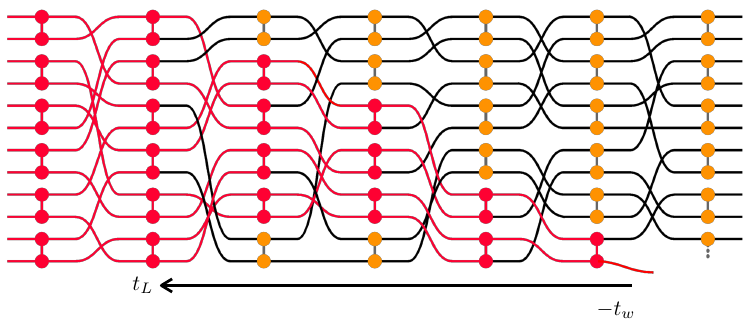
Figure 1 . Illustration of the quantum circuit representing the future interior of the black hole dual to thermofield double perturbed from the left